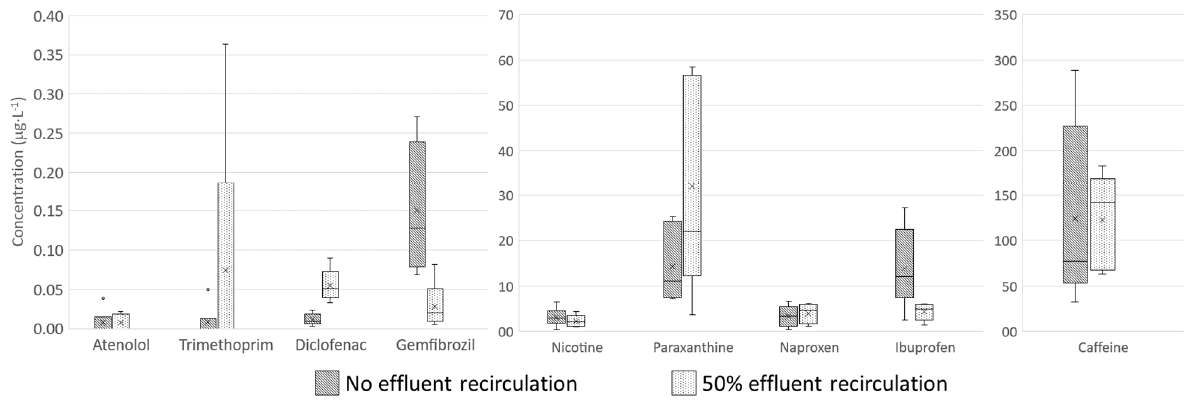
Figure 6. Concentrations of detected compounds in raw influent samples for the periods of 0% re- circulation (2018) and 50% recirculation (2019). recirculation (2018) and 50% recirculation